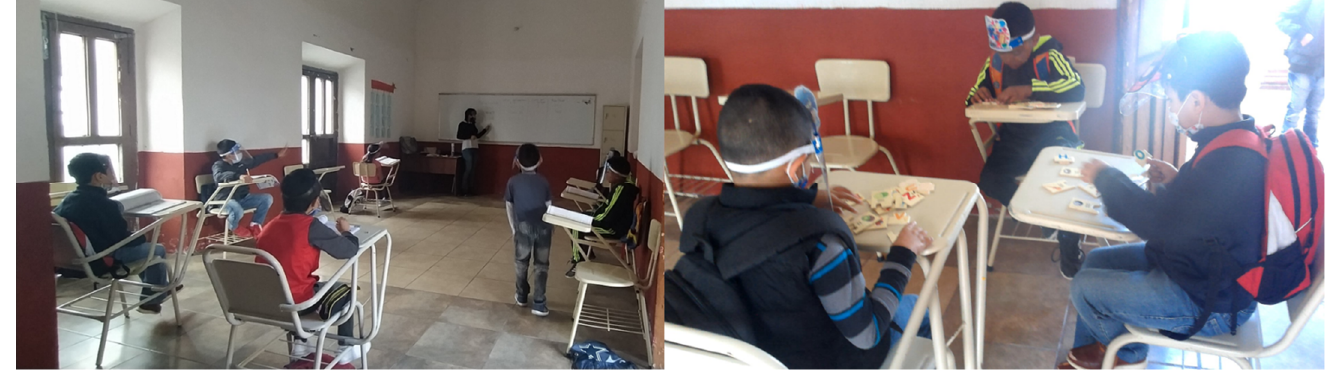
Figure A3. The first impressions on the use of virtual reality environments for teachers ( a ) and children ( b ).